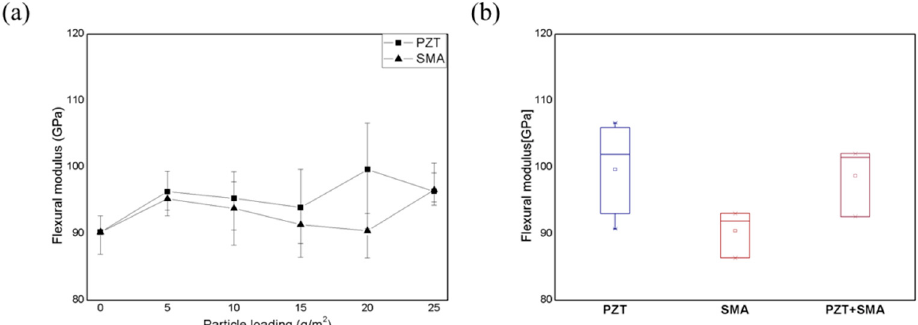
Figure 10. Flexural modulus of the CFRP specimens with ( a ) PZT- and SMA-particle-dispersed mixture films for different particle loadings and ( b ) PZT-, SMA-, and PZT 10 g/m 2 loading/SMA 10 g/m 2 loading mixed-particle-dispersed mixture films.